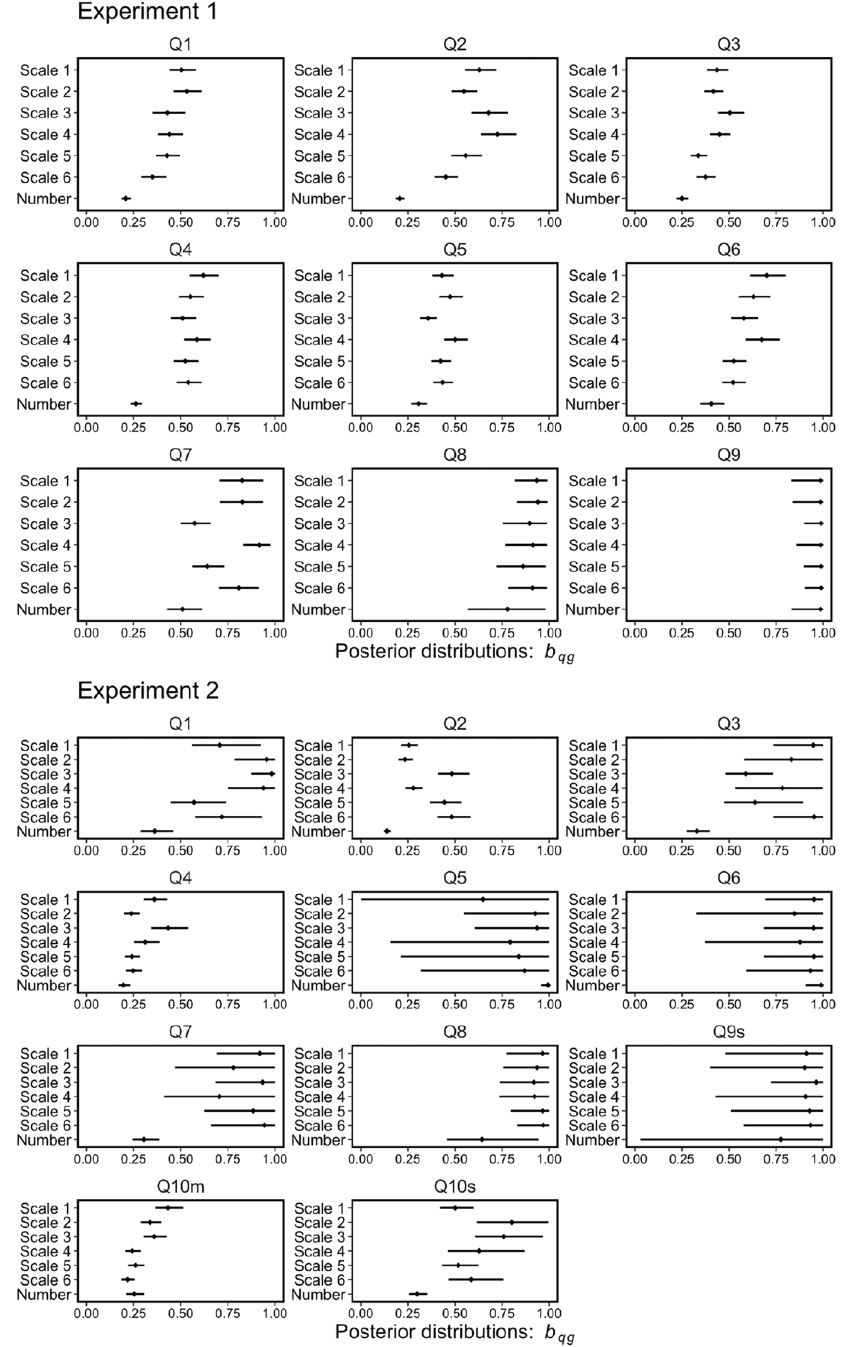
Figure 10. Posterior distributions of the parameters, b qg , in Eq. (3). The point (or error bar) indicates median (or 95% Bayesian credible